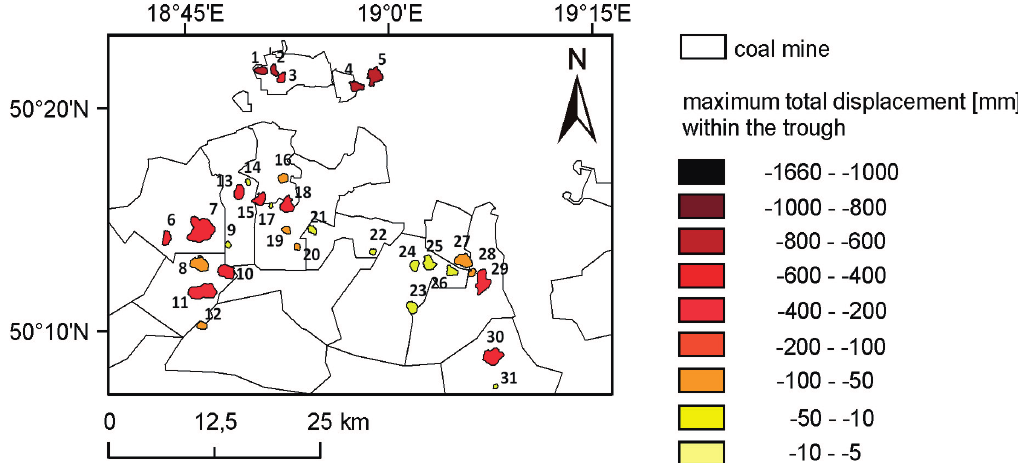
Figure 8. Resulting maximum cumulated total displacement measured in the subsidence troughs detected from the interferograms analysis in the Upper Silesia Coal Basin area during the period 05 July 2011–21 June